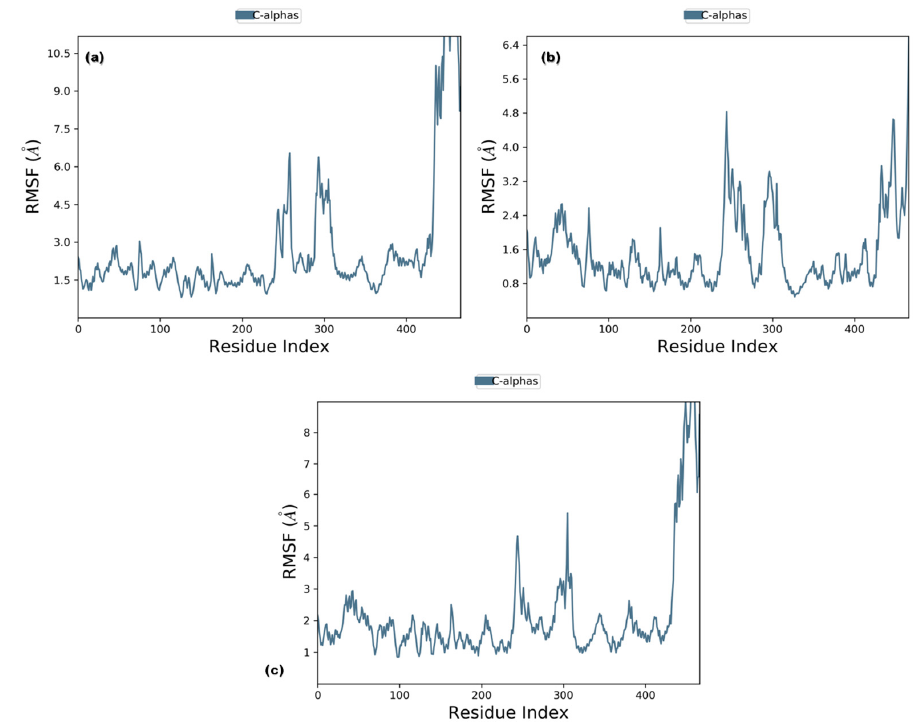
Figure 6. Root mean square fluctuation plots of 6PGD with candidate complexes (( a ) secoisolar- iciresinol, ( b ) syringaresinol and ( c ) cleomiscosin A) representing local changes during 100 ns MD simulations.